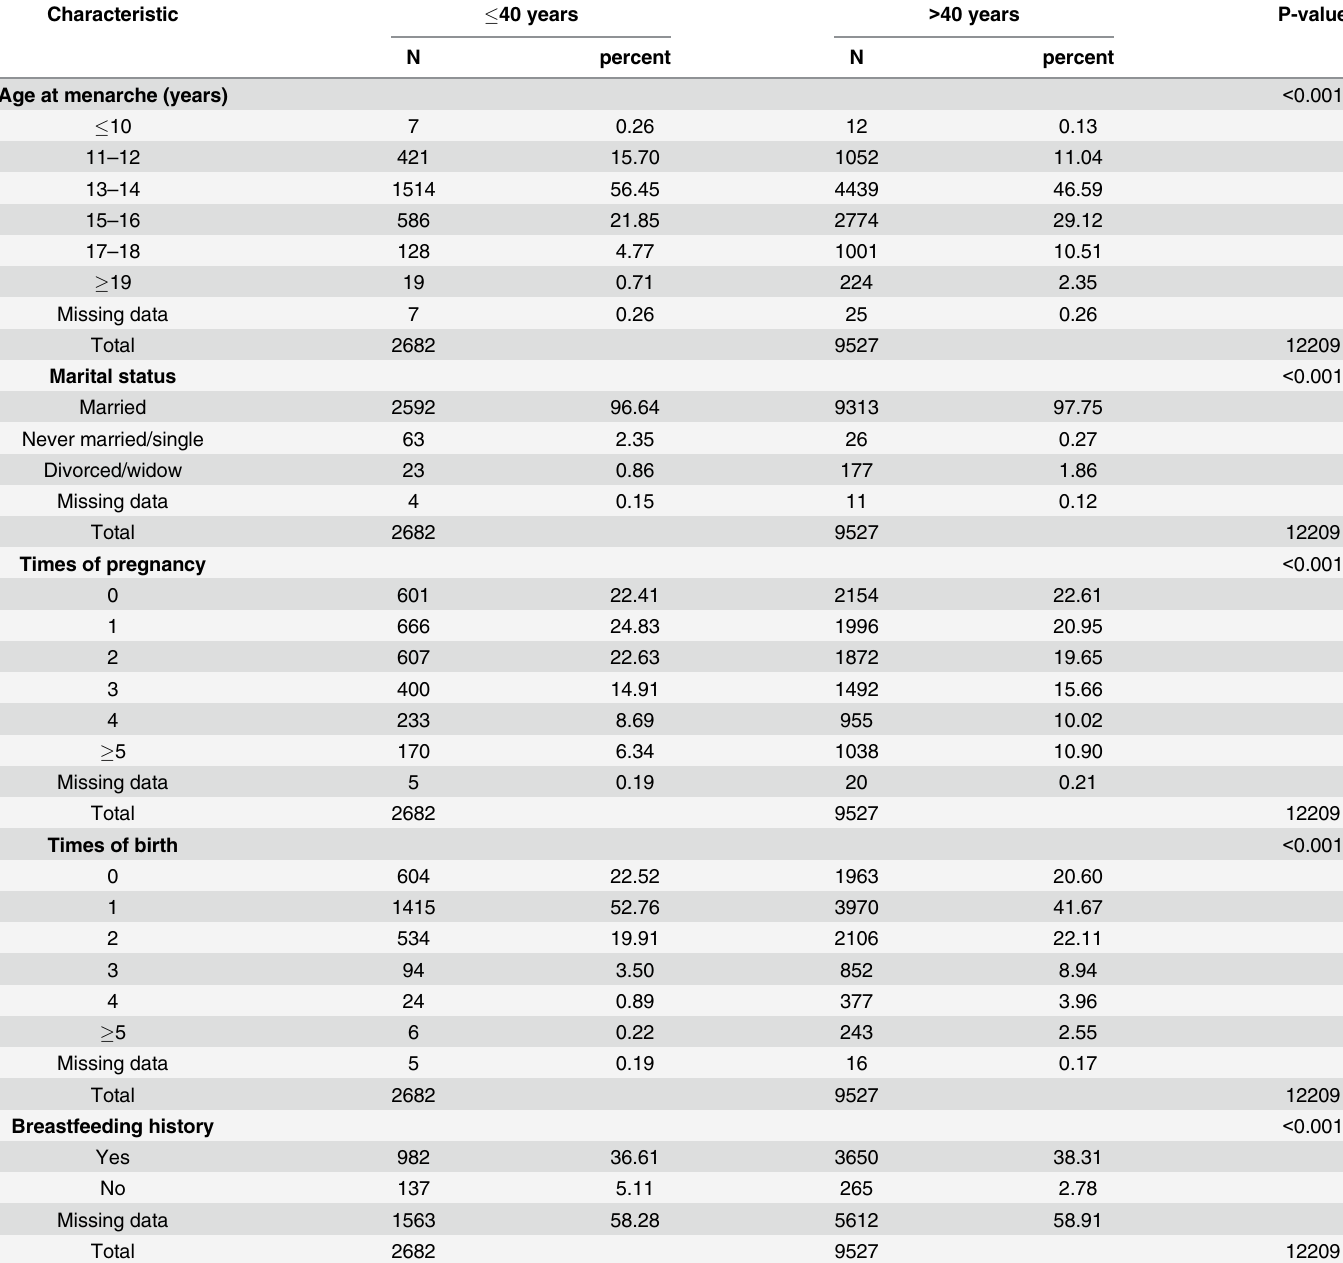
Table 1. Comparison of breast cancer risk factors between young ( (cid:1) 40 years) and older ( > 40 years) female breast cancer patients.